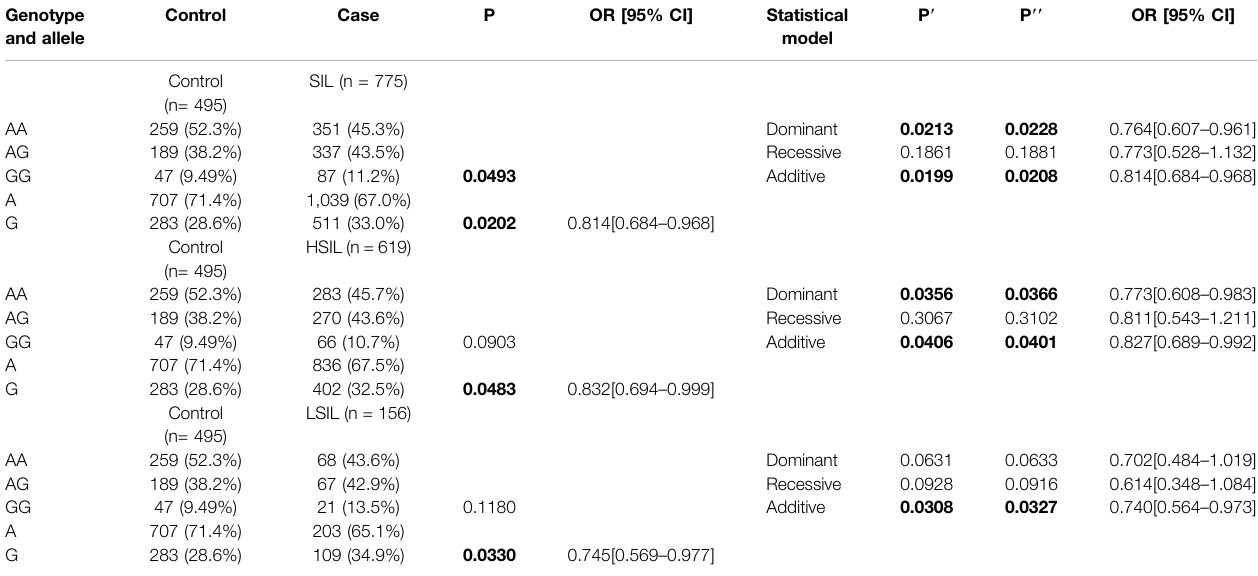
TABLE 3 | Comparison of genotypes and allele distribution frequencies between the SIL group and its subgroups with the healthy control group. Genotype and allele